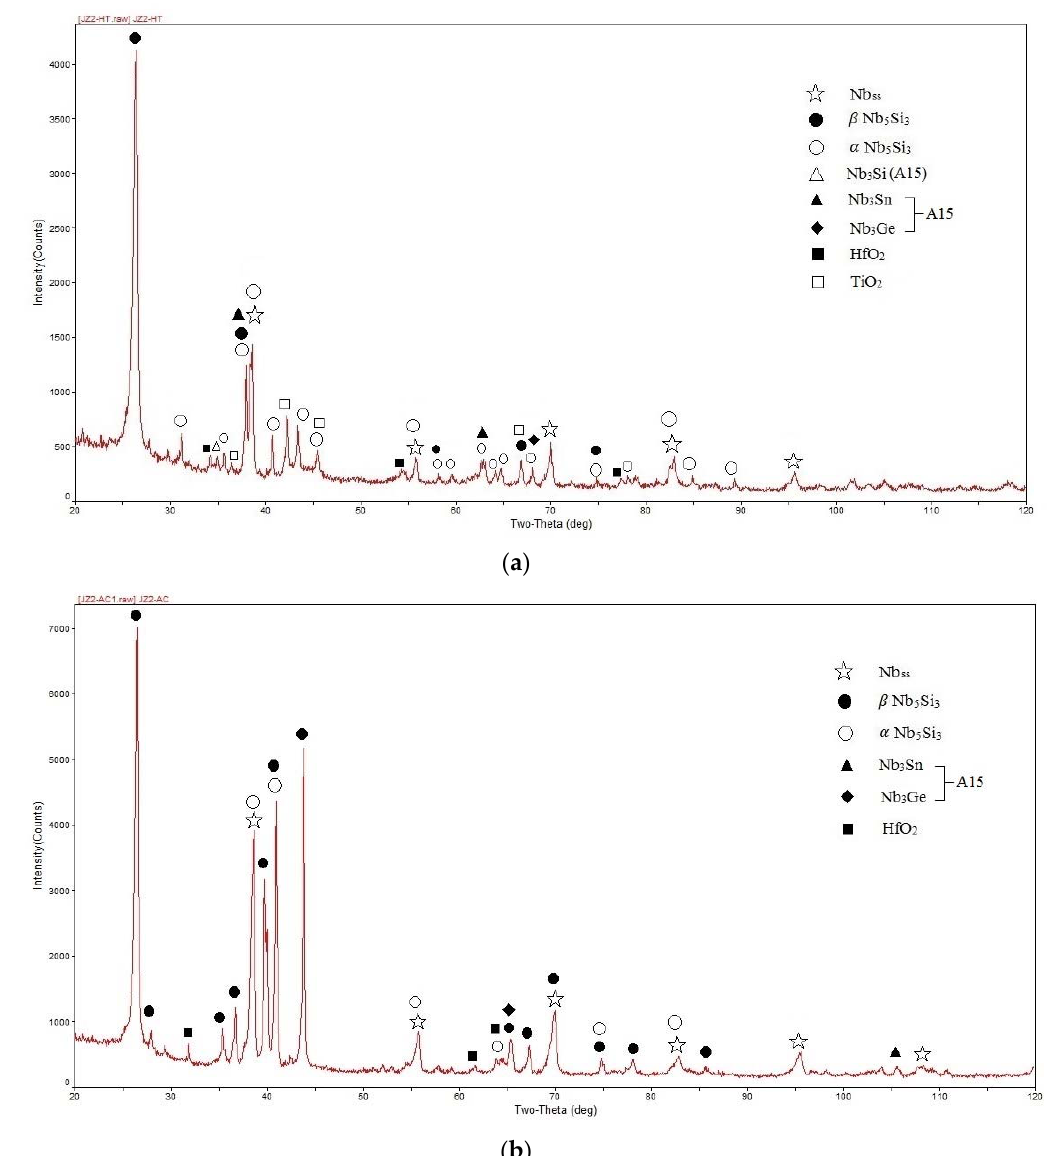
ff ractograms of the ( a ) as-cast and ( b ) heat-treated alloy Figure 4. X ‐ ray diffractograms of the ( a ) as ‐ cast and ( b ) heat ‐ treated alloy JZ2. Figure 4. X-ray di